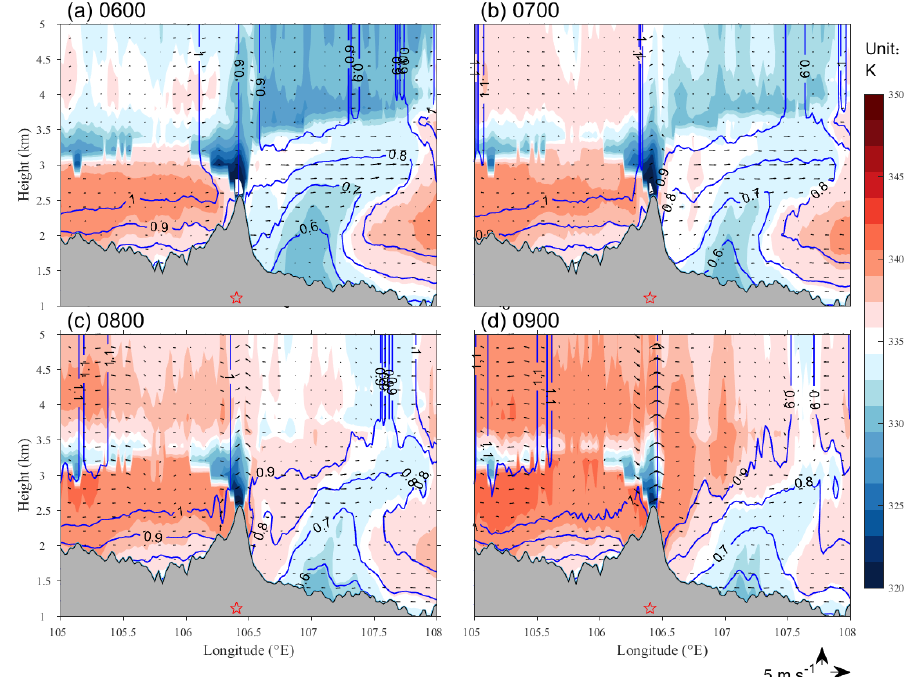
Figure 6. Cross-section of simulated pseudo-equivalent temperature (shaded, units: K) and specific humidity (blue solid lines, units: g kg − 1 ) and wind field (black vectors, units: m s − 1 ) along 35.26 ◦ N. ( a ) 0600, ( b ) 0700, ( c ) 0800, and ( d ) 0900 LST. The gray-shaded area is the terrain, and the red pentagram indicates the location of A1.